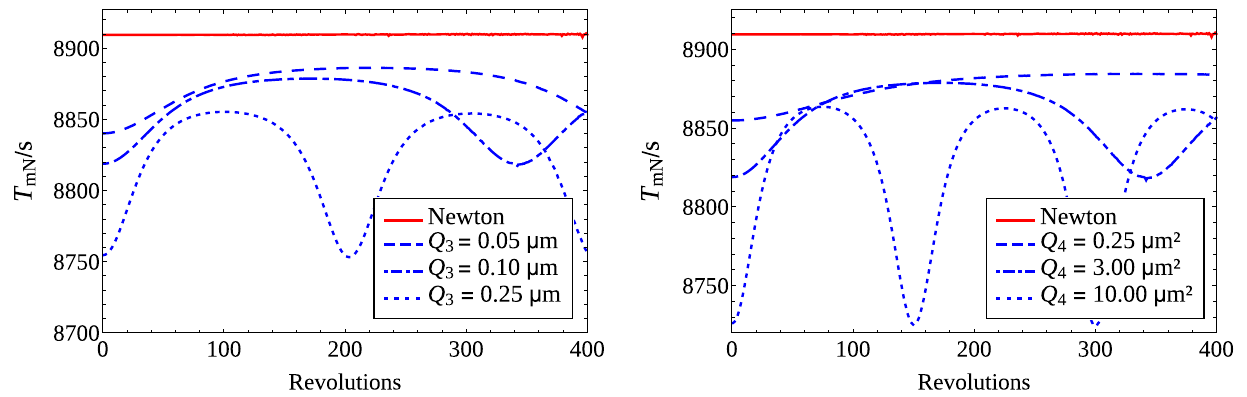
Fig. 10 Evolution of the orbital period of S around P (in seconds) dur- ing the first 400 revolutions for different values of the parameters in the mN-potential. In each panel we keep constant two parameters and vary the last one, being it Q 3 on the left (for Q 2 = 0 . 001, Q 4 = 3 μ m 2 )